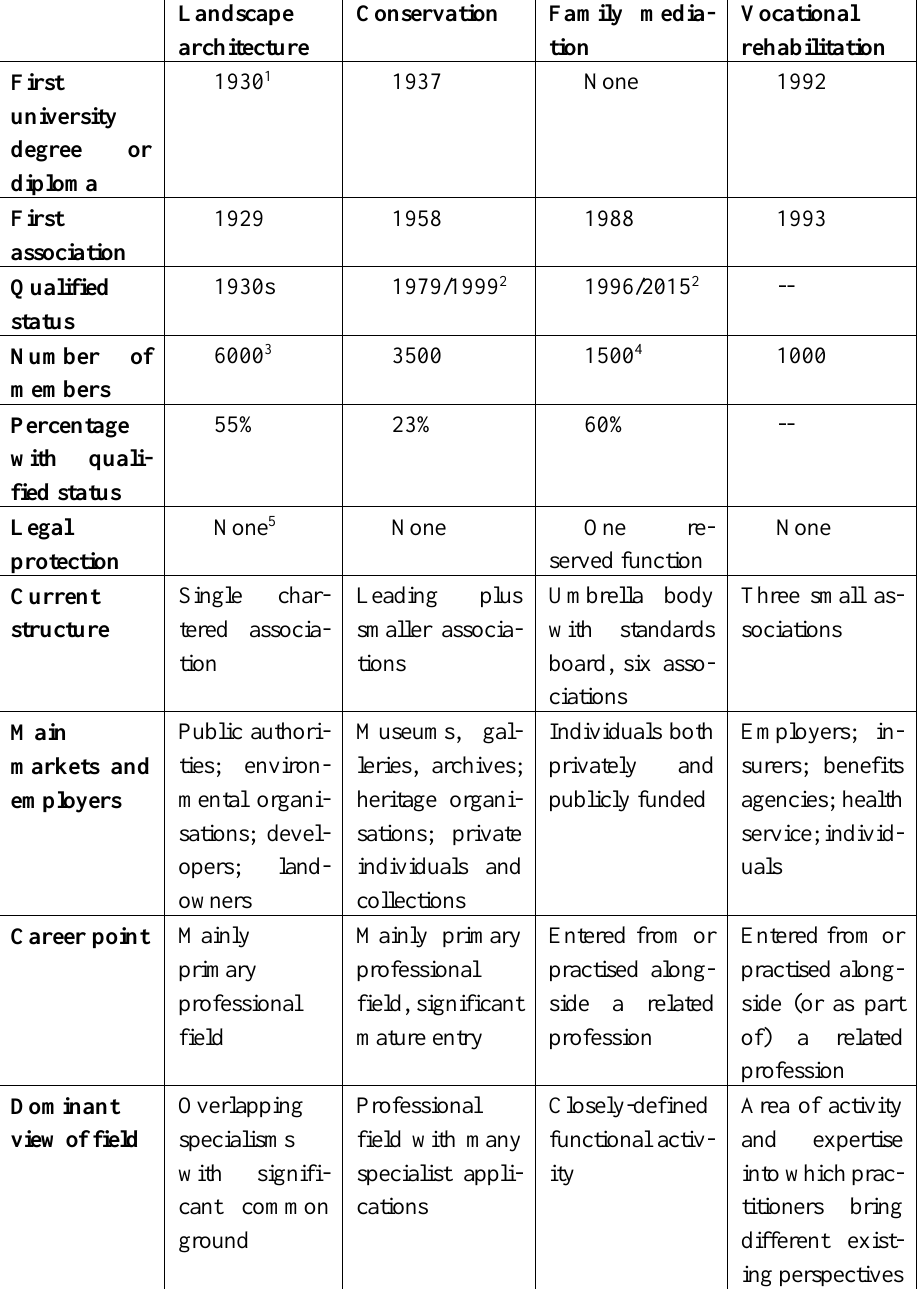
The professional